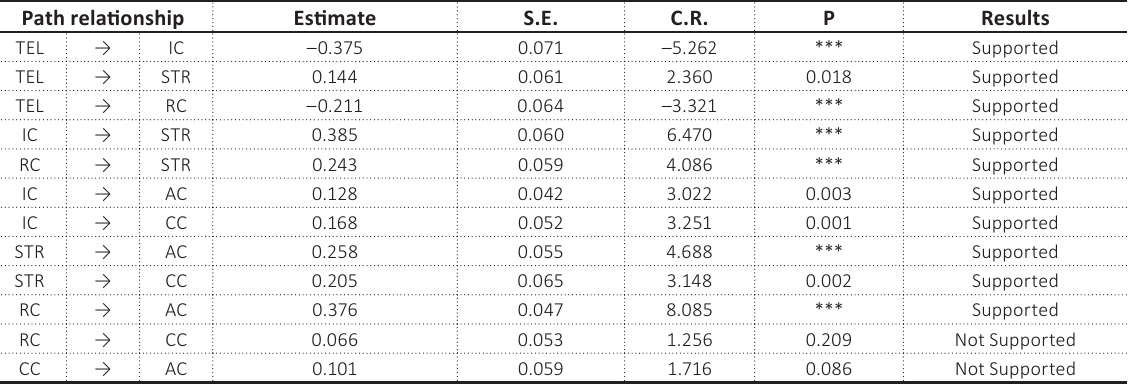
Table 8. Test results